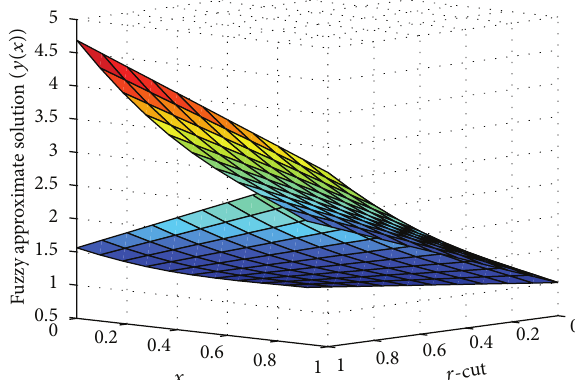
Figure 3: The Fuzzy approximate solution of Example 52, Case 1. 𝛼 = 0.85, 𝑚 = 4 .